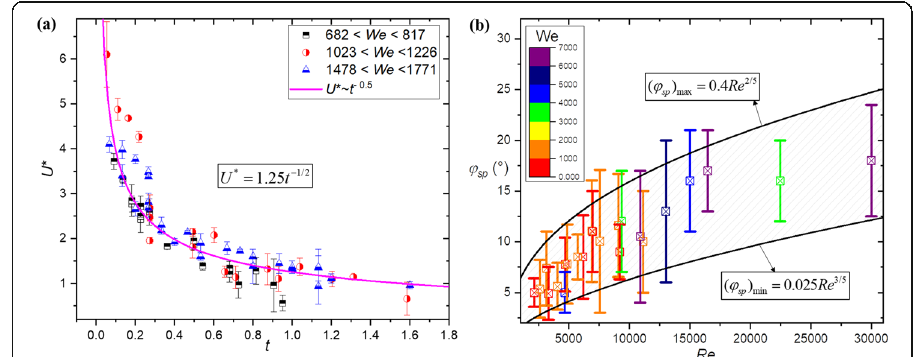
Fig. 6 a Variation tendency of the dimensionless splashing velocity of secondary droplets U * over time t . b Relation between the distribution range of splashing angle and Reynolds number Re . The symbol color represents the range of Weber number